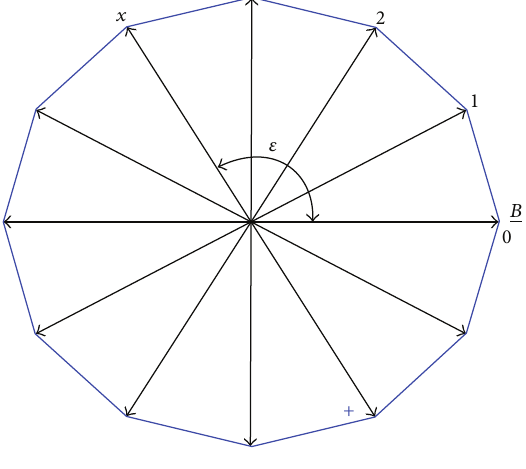
Figure 6: Current vector regulation based on voltage space vector. Figure 7: Positioning star diagram.